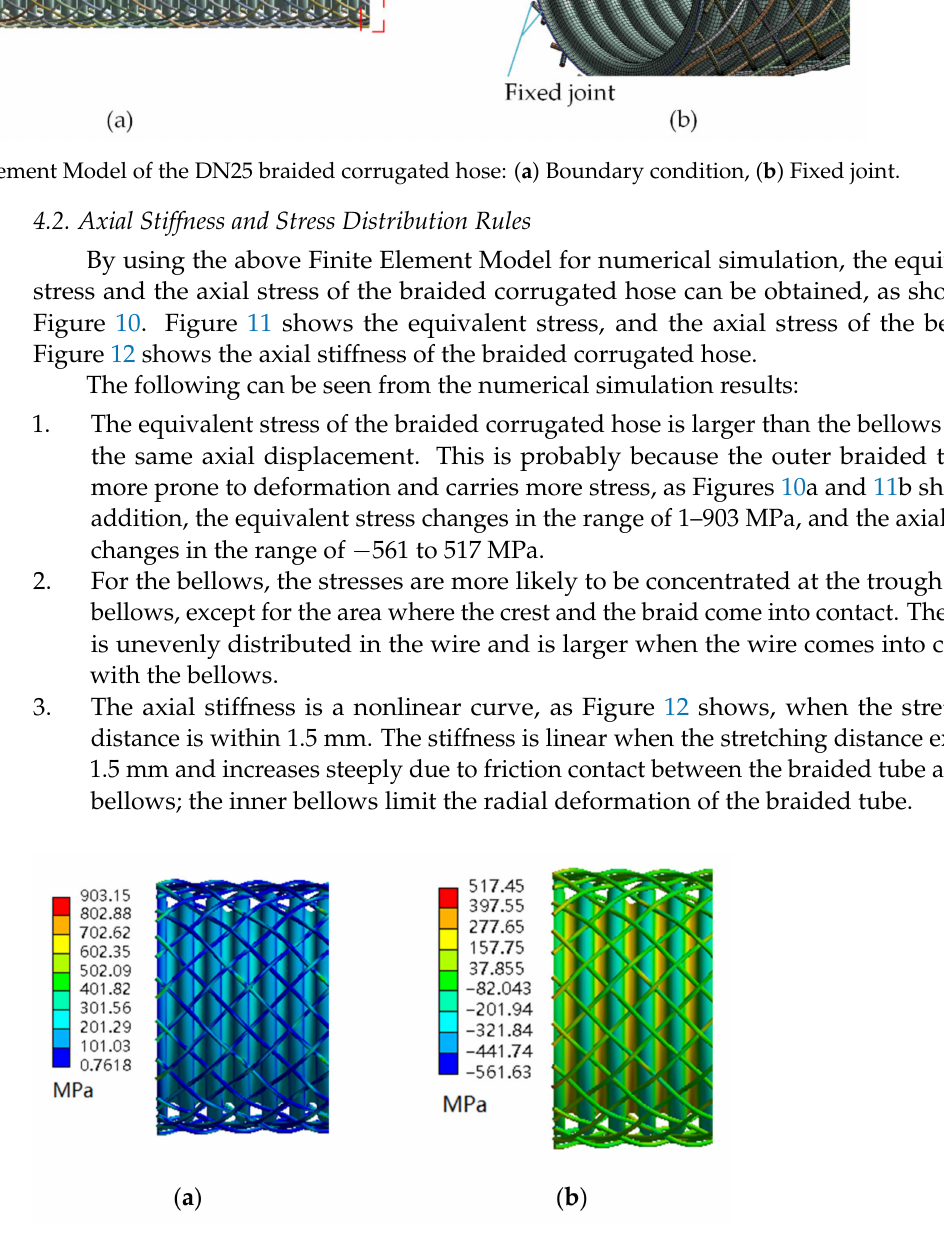
Figure 10. Stress diagrams of the DN25 braided corrugated hose: ( a ) Equivalent stress, ( b ) Axial